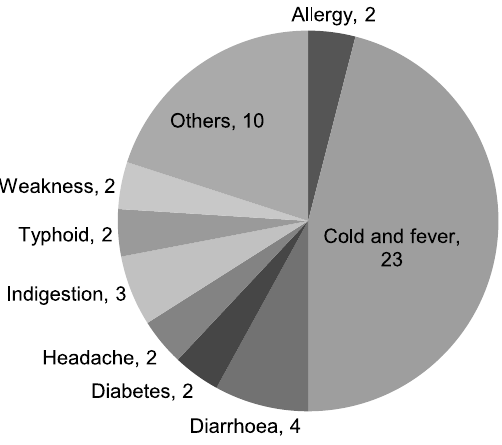
Figure 2. Distribution of patients who contracted doctors using mobile phone by type of disease.